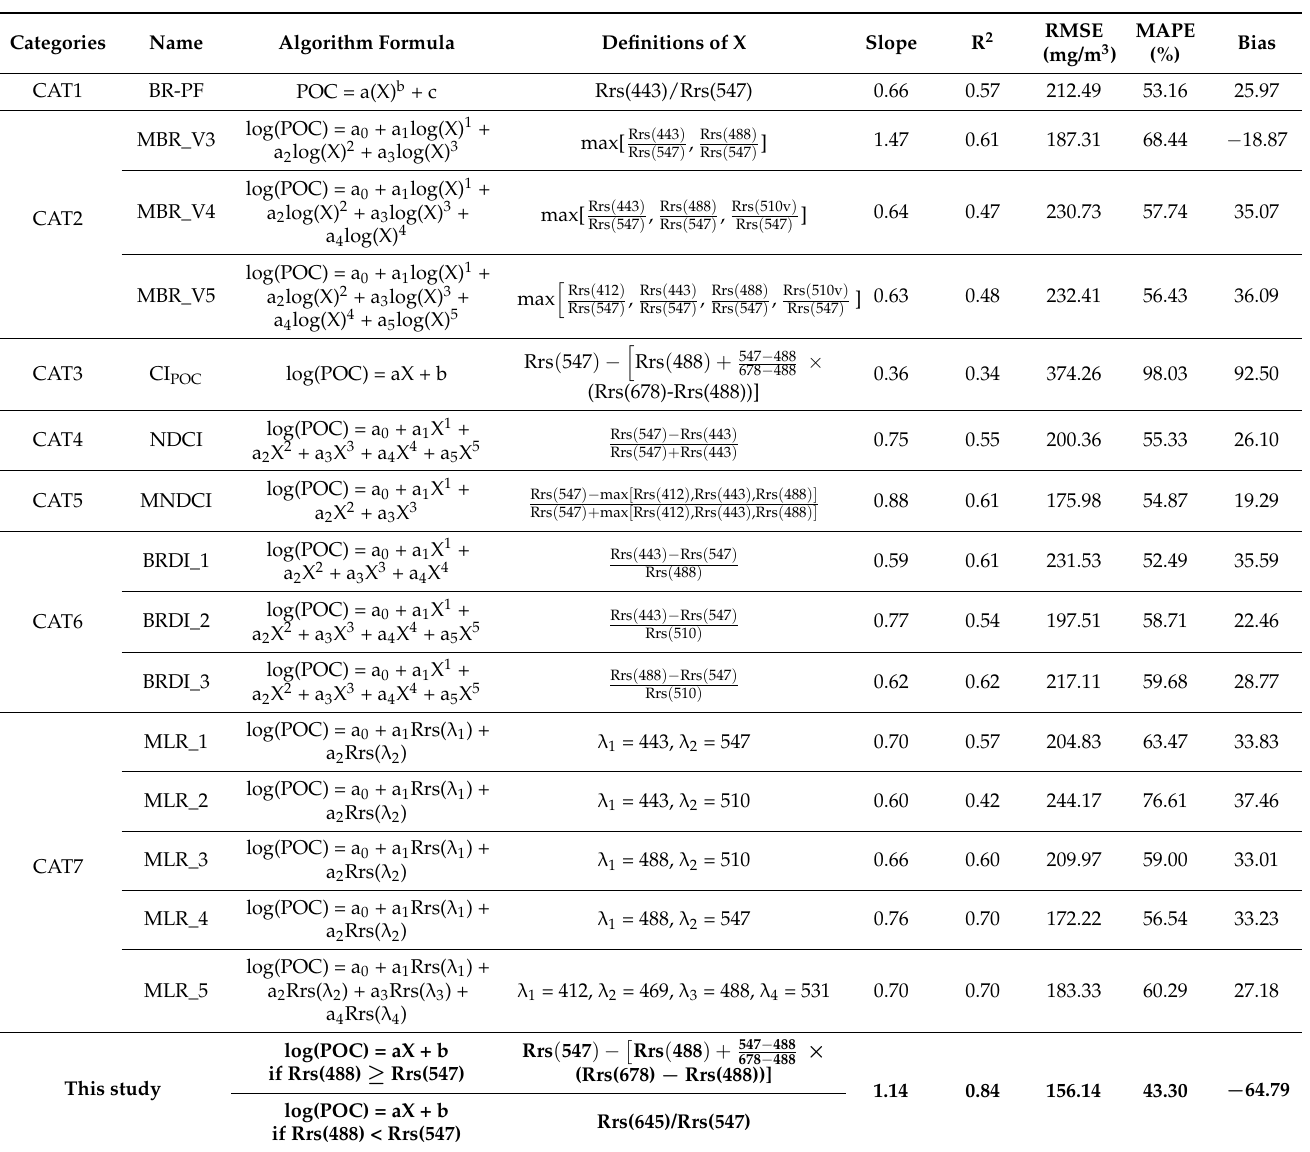
Table 1. Model Comparisons of local adjusted particulate organic carbon (POC) algorithms in the East China